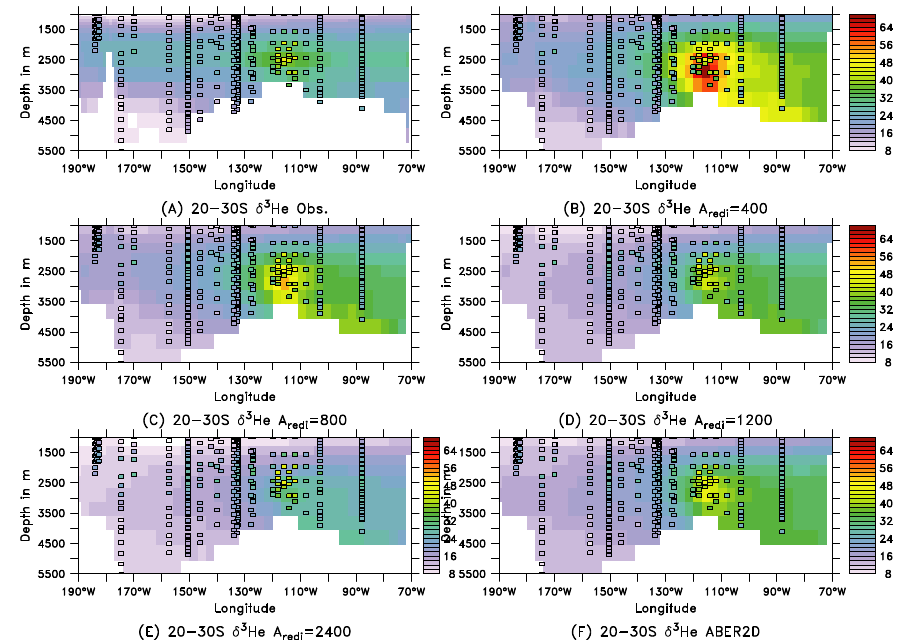
Figure 10. δ 3 He (in %) in the SE Pacific between the latitudes of 20 and 30 ◦ S. Symbols are taken from the observational data set of Bianchi et al. (2010). (a) Gridded data set of Bianchi et al. (2010) showing effects of smoothing. (b) AREDI400. (c) AREDI800. (d) AREDI1200. (e) AREDI2400. (f)